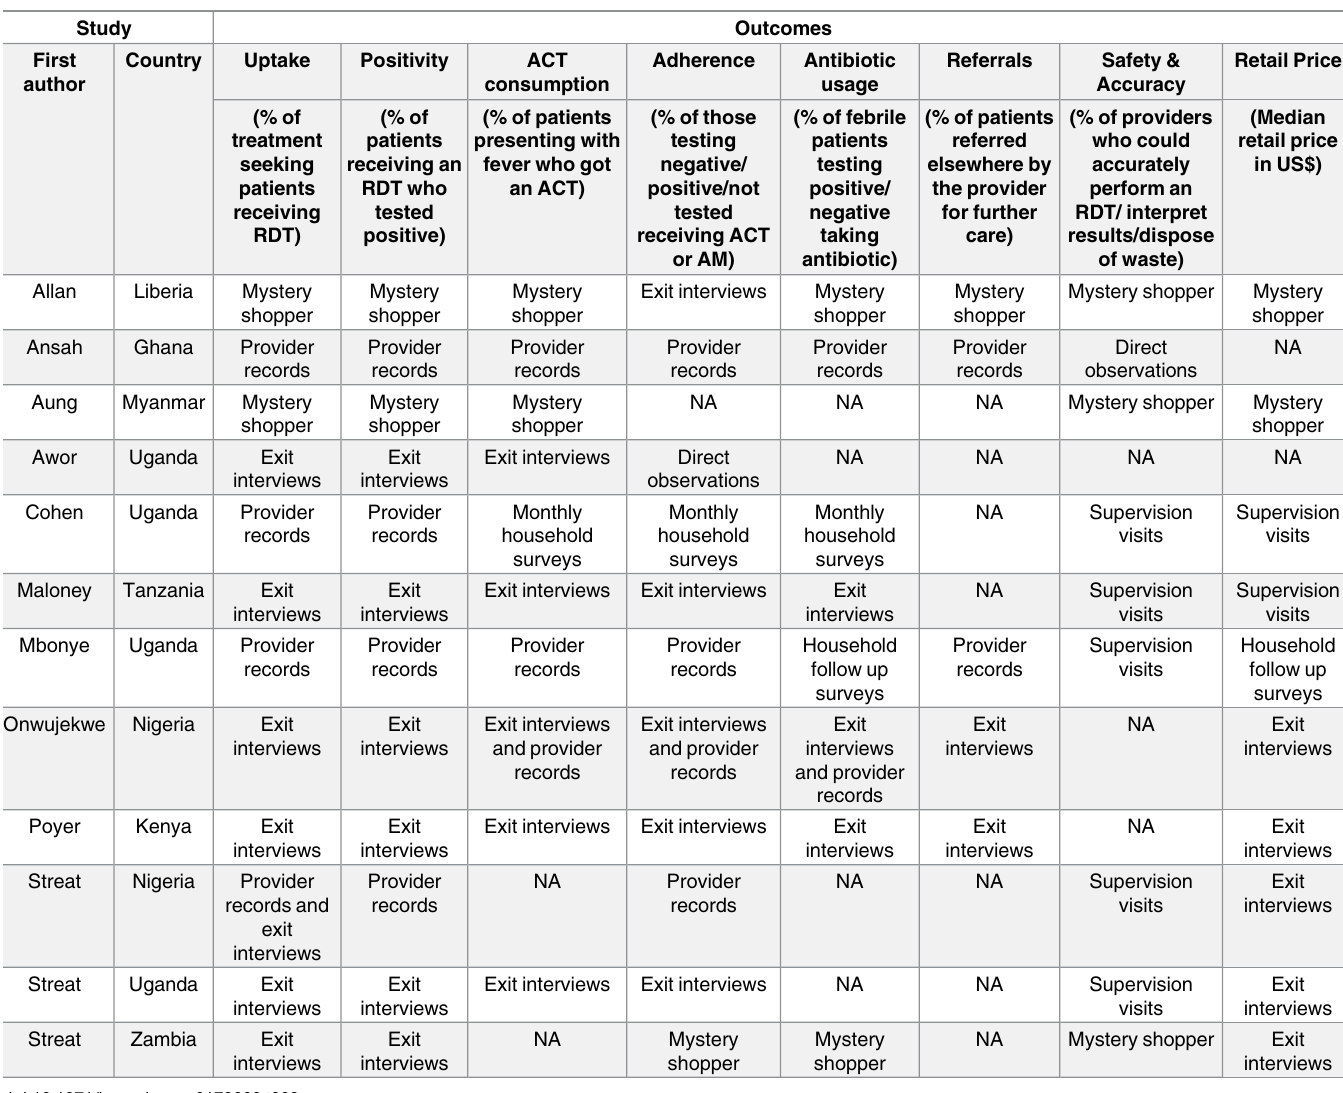
Table 3. Data collection